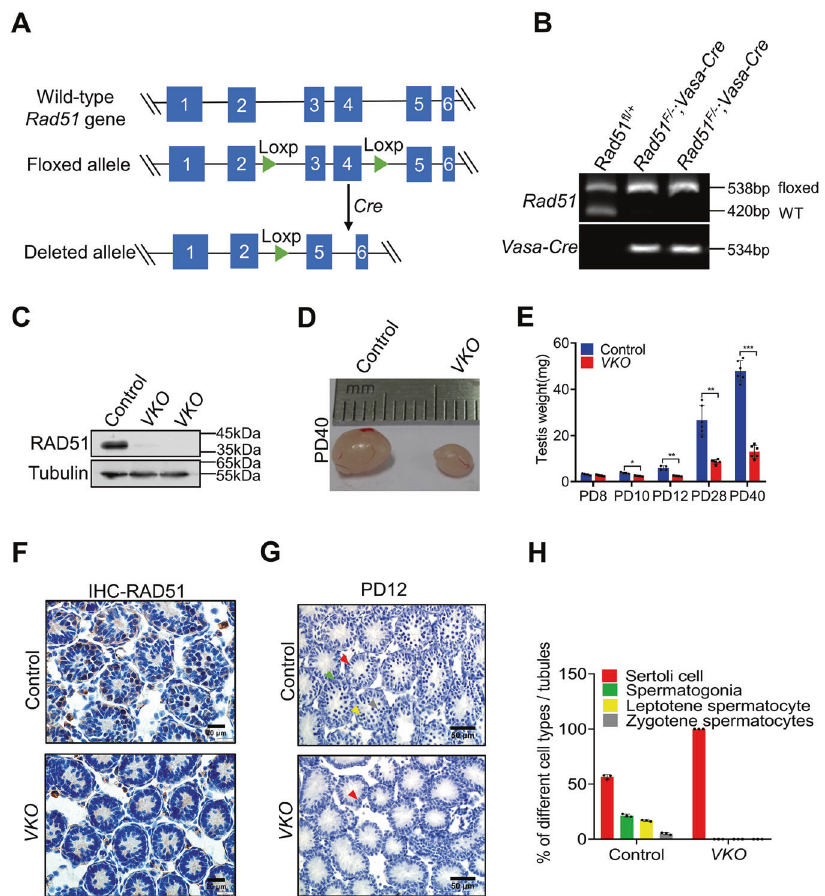
Fig. 2 Conditional disruption of RAD51 in germ cells results in sterility. A A schematic diagram illustrates the generation of the Rad51 conditional knockout mice. The strategy was to insert loxp sites to fl ank exons 3 and 4 of the mouse Rad51 gene. Cre recombinase mediated the removal of the fl oxed sequence to create a null allele. B Genotype identi fi cation of Rad51 conditional knockout mice was analyzed by PCR of tail biopsy DNA. C The knockout ef fi ciency was determined by western blotting in PD40 testes of RAD51-VKO mice compared to their littermate controls. D The size of testes was compared in RAD51-VKO males compared to their littermate controls from PD40 mice. E The testes weights at PD8 to PD40 were measured in RAD51-VKO mice and their littermate controls ( n = 5). Data are presented as means ± S.D. * p < 0.05, ** p < 0.01, *** p < 0.001. F Immunohistochemical staining of mouse seminiferous tubules shows the ef fi ciency of PD8 RAD51-VKO mice and their littermate control. Scale bars are 20 μ m. G Haematoxylin staining was conducted in seminiferous tubules to analyze the number and type of testicular cells in PD12 RAD51-VKO mice and their littermate controls. Scale bar, 50 μ m. (red triangles: Sertoli cell; green triangles: spermatogonia; yellow triangles: leptotene spermatocyte; gray triangles: zygotene spermatocytes). H Statistics of label the different types of germ and somatic cell types to